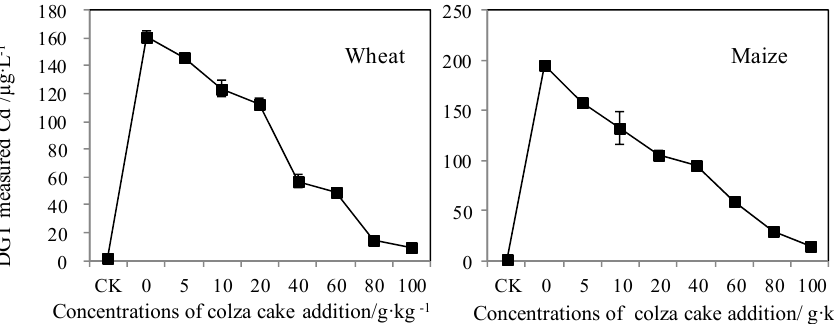
Figure 5. DGT-measured concentrations ( C DGT ) of Cd after the addition of colza cake in Cd-contaminated soils grown by wheat and maize, respectively.